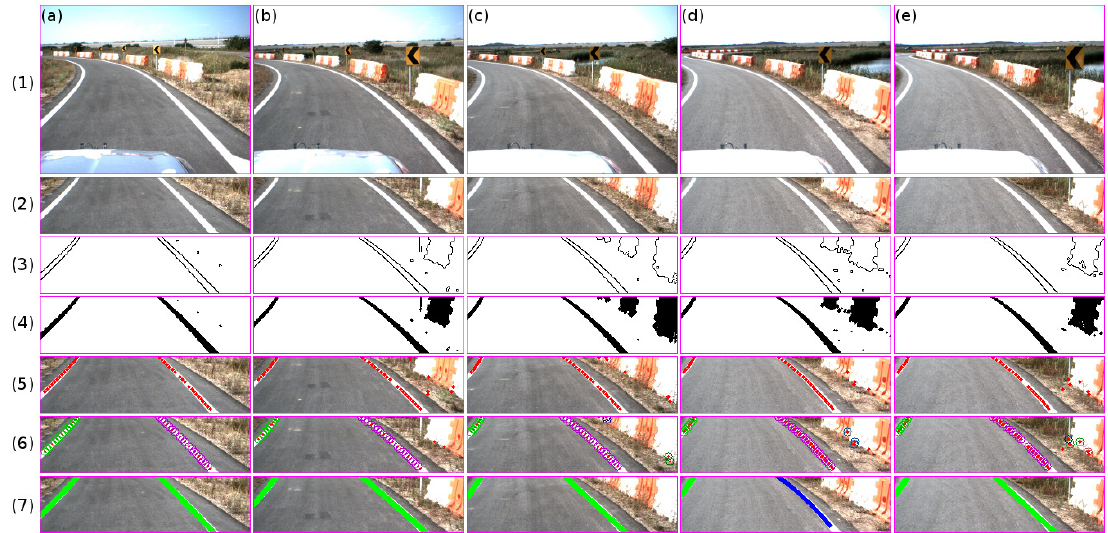
Figure 5. Lane marking results. ( a – e ) show a set of input images captured along the vehicle trajectory and their respective result of each step (from 1 to 7). The first row shows the input images. The second row shows the region of interest extraction using the speed of the vehicle. The third and fourth rows show the edge and color mask results. The fifth row shows the middle point extraction.